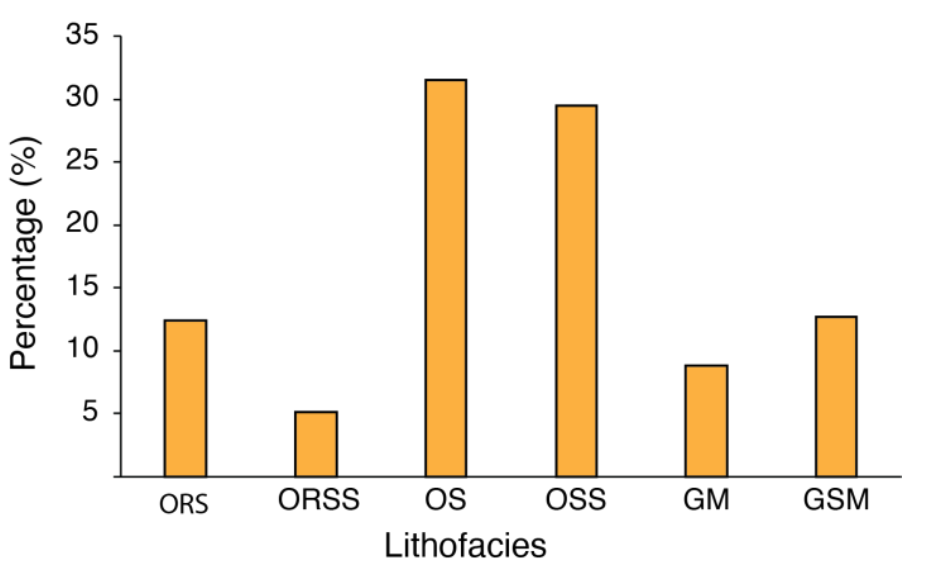
Figure 9. Distributions of the Gulong lithofacies in the datasets. Refer to text for abbreviations of lithofacies. Table 3. Precision, recall and F1-scores for 5-fold-cross-validation over machine learning models.